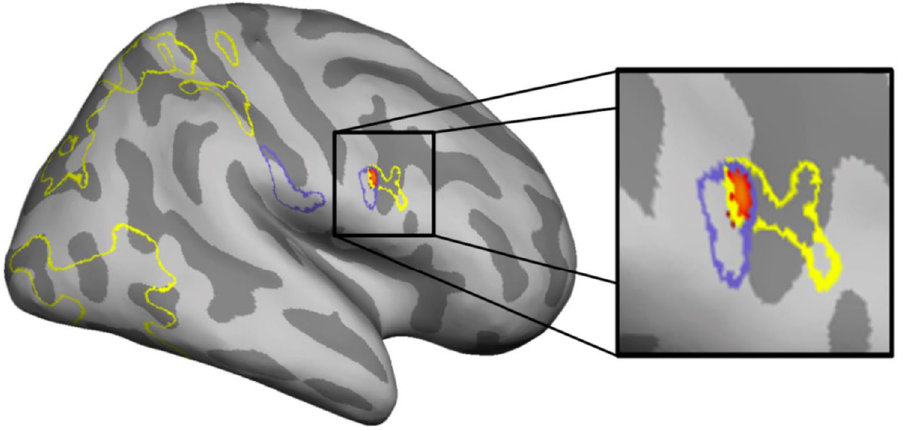
Figure 4. Covariance of BOLD response with tool-making stimulus structural complexity. Outlines corresponding to areas yielding significant correlation with the CFG (purple) and HMM (yellow) covariates describing action sequence complexity. Heatmap clusters represent the minimum of these two correlations where they overlap voxel-wise in the right pars opercularis of the inferior frontal gyrus